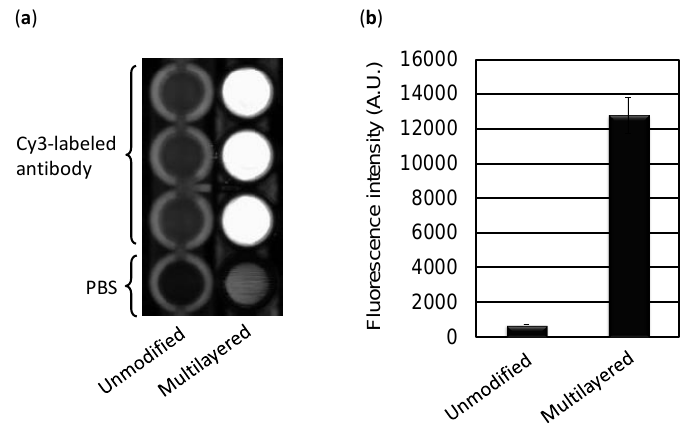
Figure 4. Enhancement of fluorescence intensity from Cy3-labeled antibody on the multilayered microplate. ( a ) Two-dimensional fluorescence image of the unmodified and multilayered microplate. PBS was added to wells of both microplates as a negative control; ( b ) Comparison of fluorescence signals. Error bars indicate the standard deviation of three measurements.